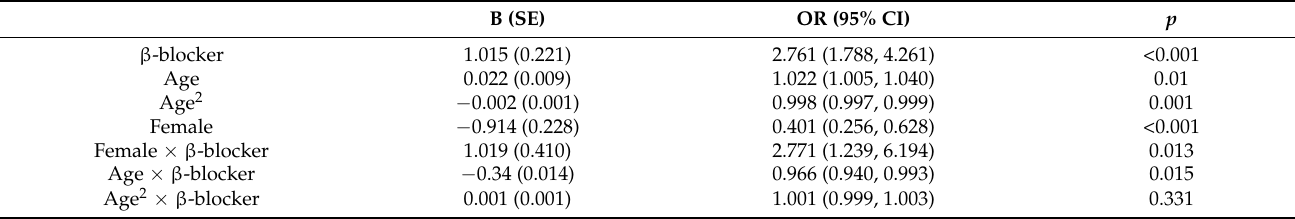
Table A1. Results of the main logistic regression model to evaluate sex and age-related differences in heart rate performance curves (HRPC) dependent on